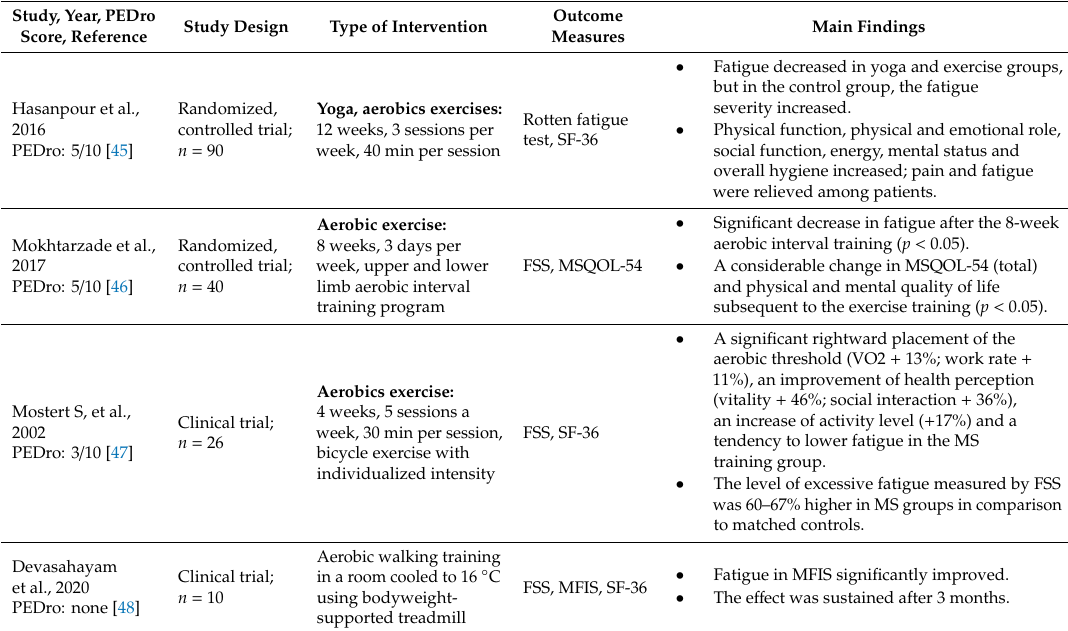
Table 2. Di ff erent types of physical activity performed by multiple sclerosis (MS) patients with fatigue. Study, Year, PEDro Score,